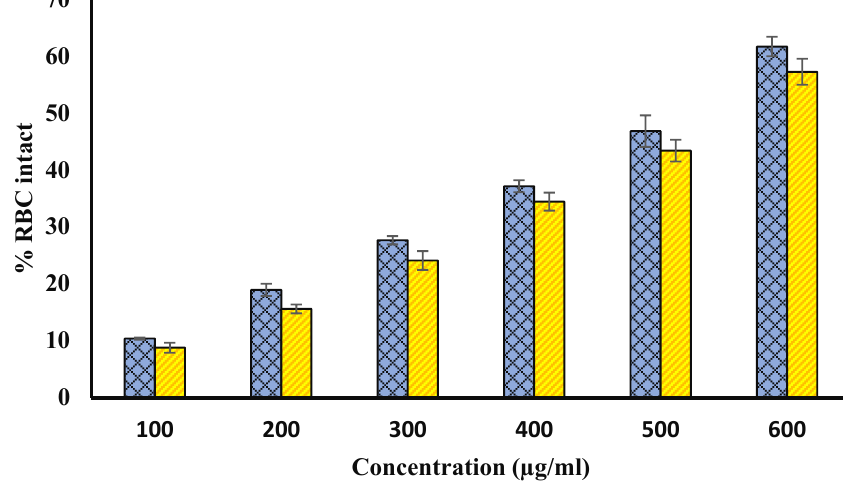
Figure 8. Protection from hyposalinity-induced hemolysis. The figure shows that methanol extract of Ajwa seed and fruit pulp provide protection for hyposalinity-induced hemolysis in a concentration-dependent manner. Blue bars show various concentrations (100, 200, 300, 400, 500, and 600 µ g/mL) of Ajwa fruit pulp. Yellow columns represent various concentrations (100, 200, 300, 400, 500, and 600 µ g/mL) of seed extract. The results are presented as means ± SEM ( n = 3, p < 0.05).